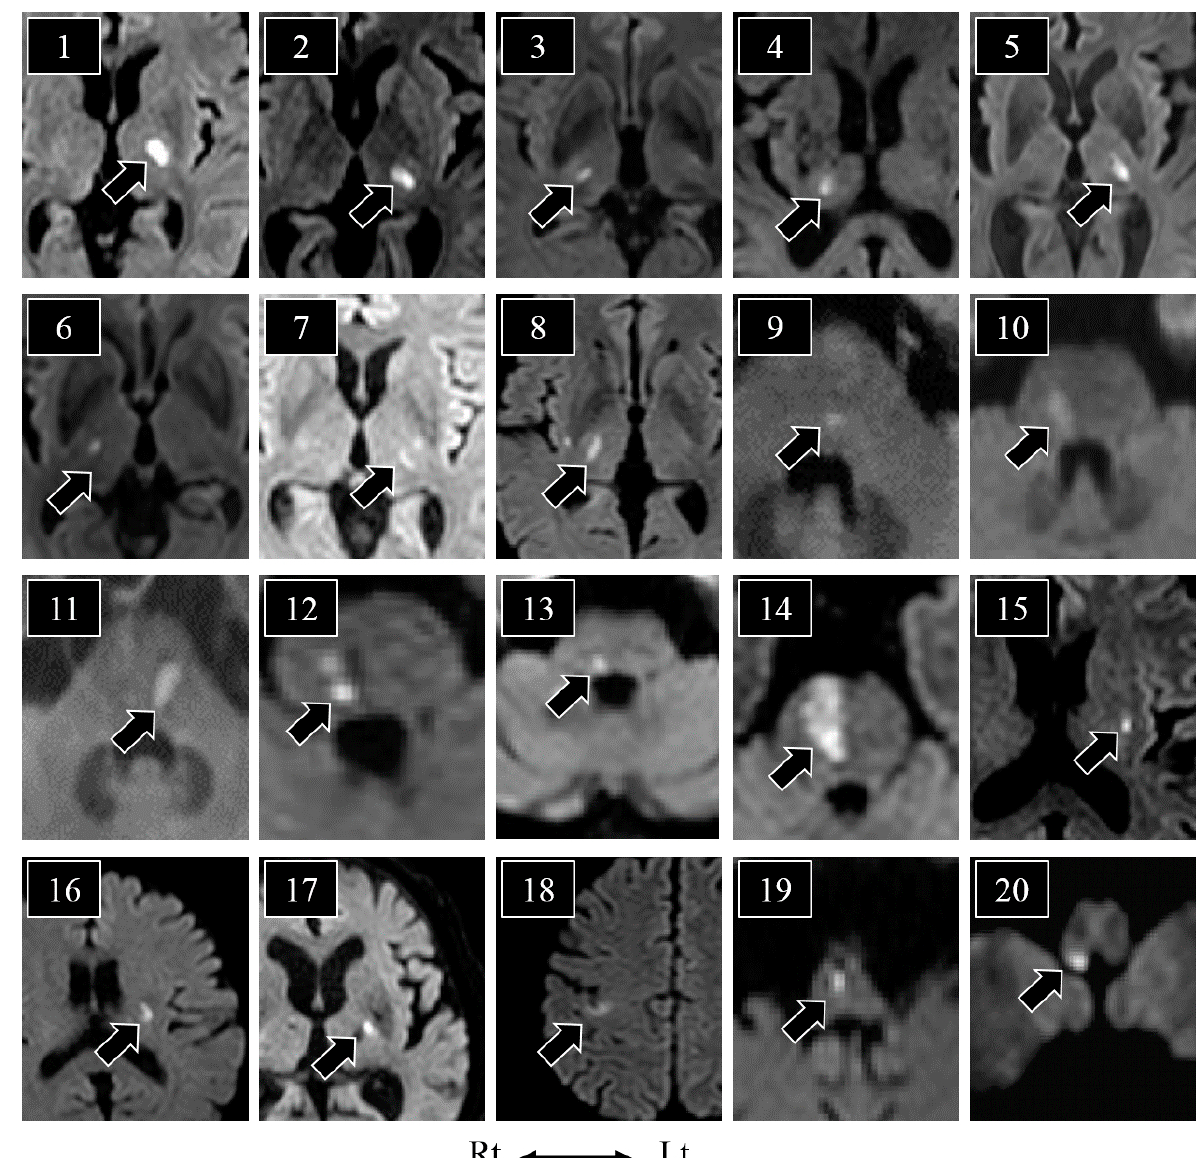
Figure 2. Di ff usion-weighted magnetic resonance imaging of patients with subjective sensory dis- turbances/hypoesthesia. The black arrowheads show the ischemic lesions. Lesions were detected in the thalamus ( n = 8; patients 1–8), pontine tegmentum ( n = 5; patients 9–13), pontine base to tegmentum ( n = 1; patient 14), putamen ( n = 1; patient 15), corona radiata ( n = 1; patient 16), posterior limb of the internal capsule ( n = 1; patient 17), cerebral cortex ( n = 1; patient 18), medial medulla ( n = 1; patient 19), and lateral medulla ( n = 1; patient 20). Lt: left, Rt: right.